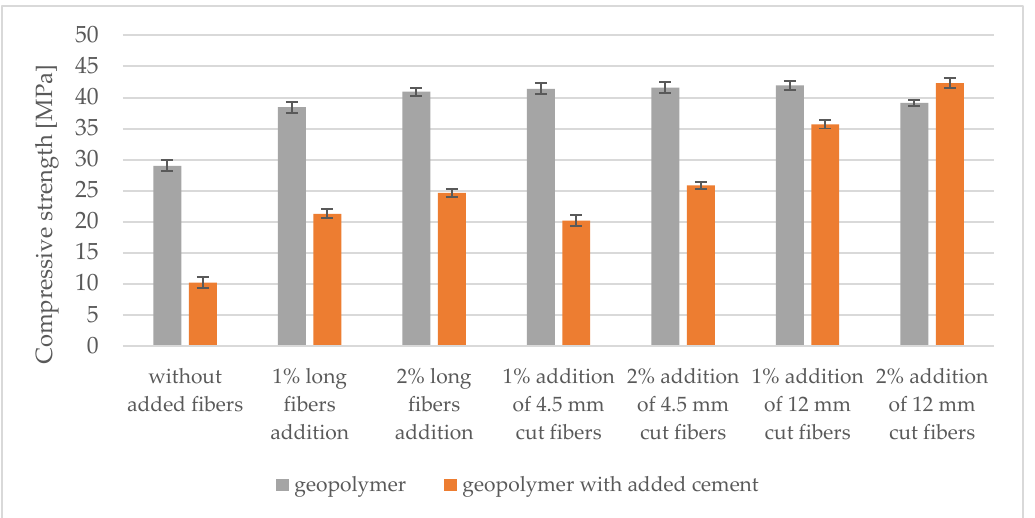
Figure 11. Compressive strength of non E-glass fiber-reinforced cementitious geopolymers and geopolymers with added cement.